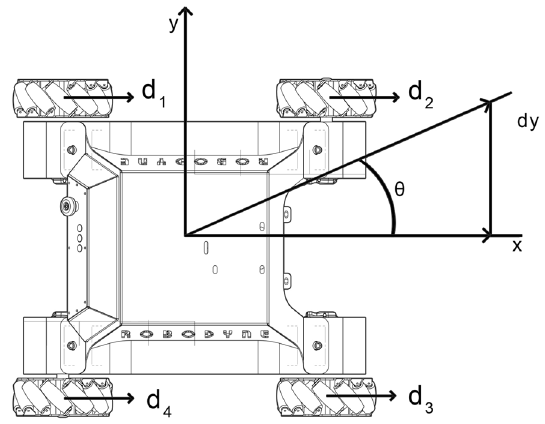
Figure 7. The straying angle caused by slipping episodes incurred by the mecanum